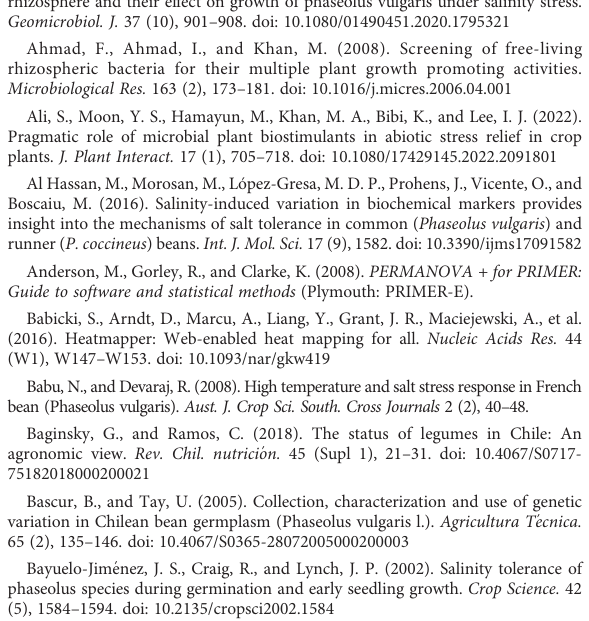
SUPPLEMENTARY FIGURE 1 LB plate showing mucoid colony appearance of (A) B. proteolyticus Cyn1 and (B) B. safensis Cyn2; (C) Comparison of different plant growth promoting characters of PGPB isolates Cyn1 and